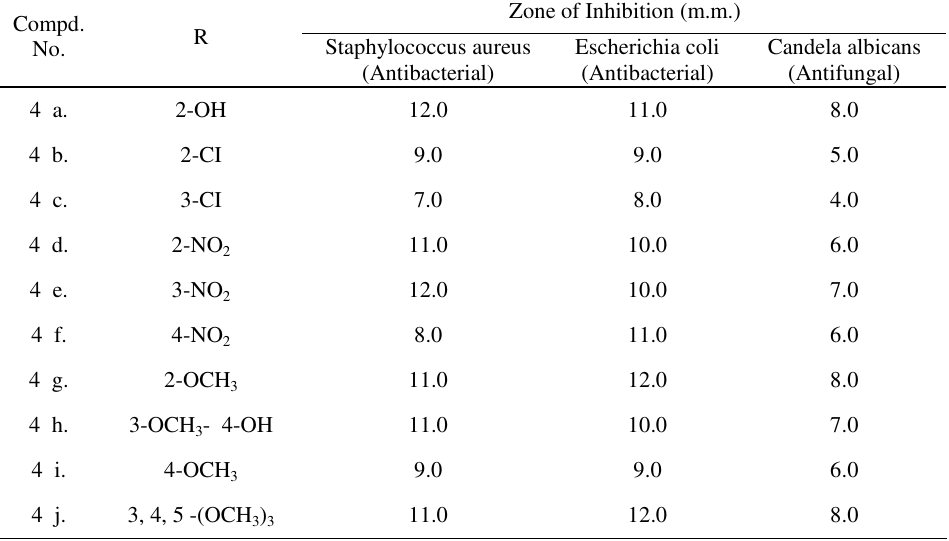
Table 10 . ANTIMICROBIAL DATA OF COMPOUNDS [4(a-j)]